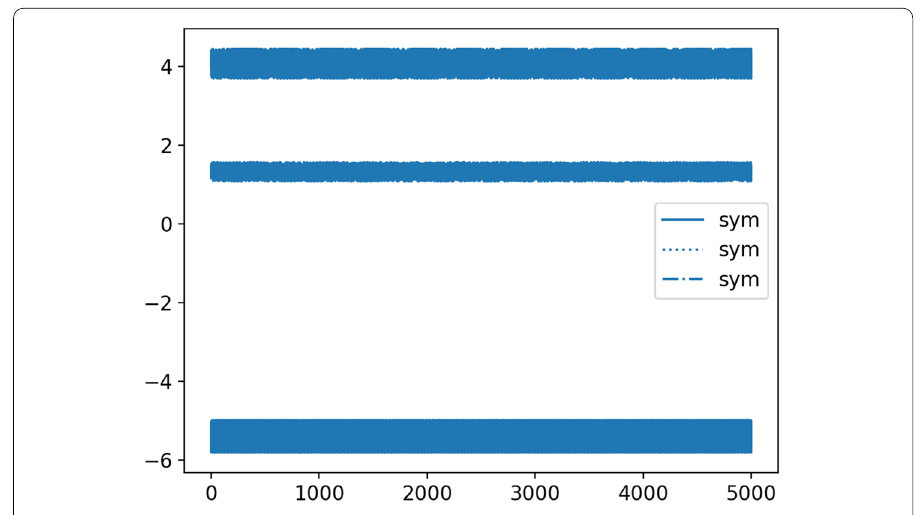
Fig. 5 Toda lattice. Evolution of the eigenvalues of L with the symplectic Euler scheme and (cid:5) t = 10 − 1